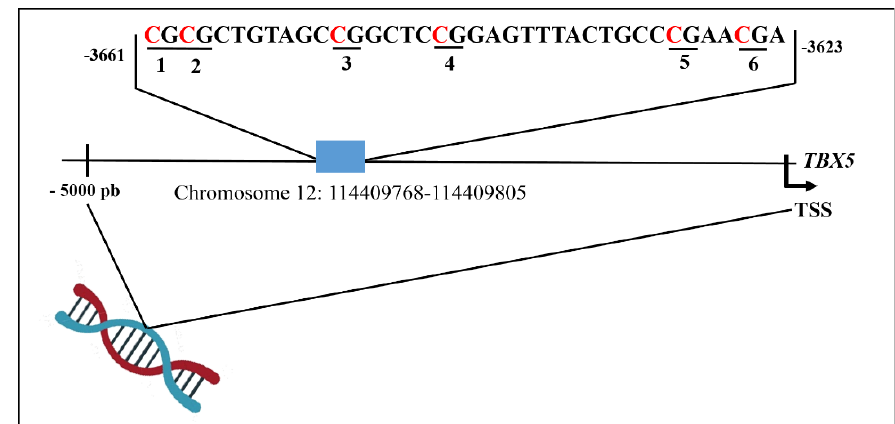
Figure 1. Schematic representation of distribution the CpG sites analysed in the TBX5 gene promoter. Numbers 1-6 refer to CpG site within the sequence of TBX5 . TSS, transcription start site.